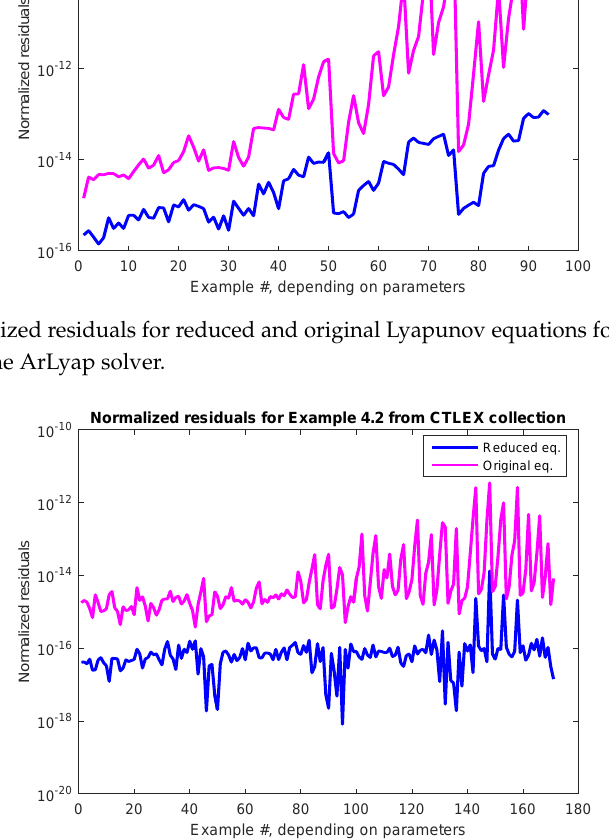
Figure 18. Normalized residuals for reduced and original Lyapunov equations for CTLEX 4.2 series of examples, using the ArLyap solver; tolerance ε 2 M